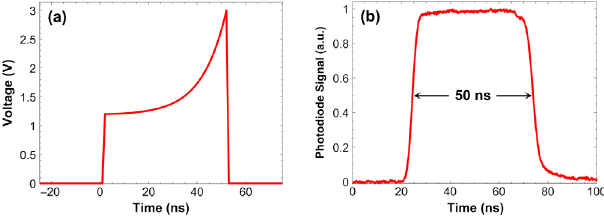
FIG. 8. (a) 50 ns control waveform on EOM. (b) A typical UV pulse waveform with 2.8 MW peak power detected by a fast